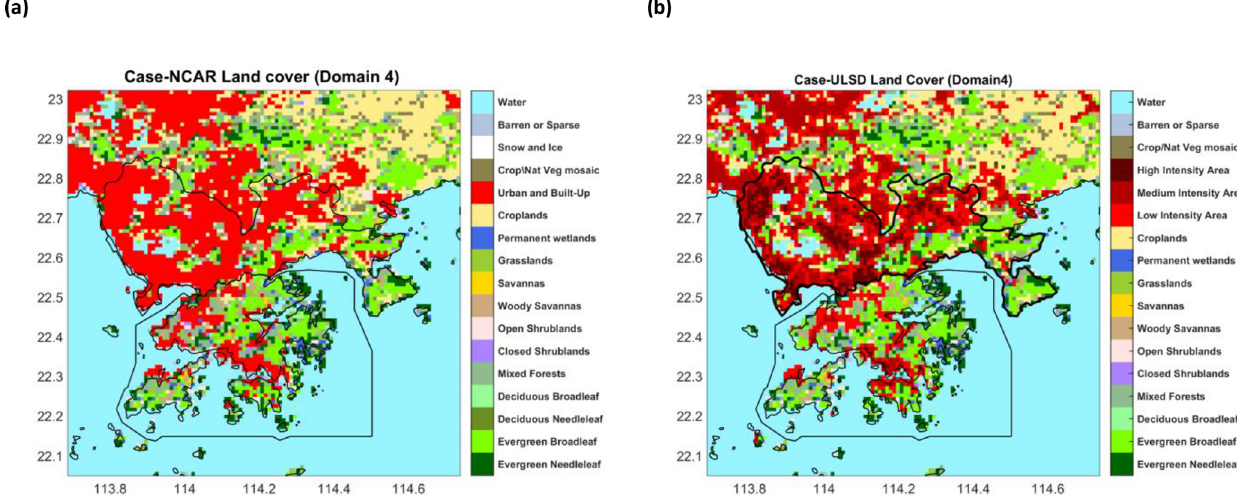
Figure 2. The land covers provided by NCAR originally (a) , and the adjusted land covers based on the urban land surface dataset (b) . Data source: Li et al. (2019a,